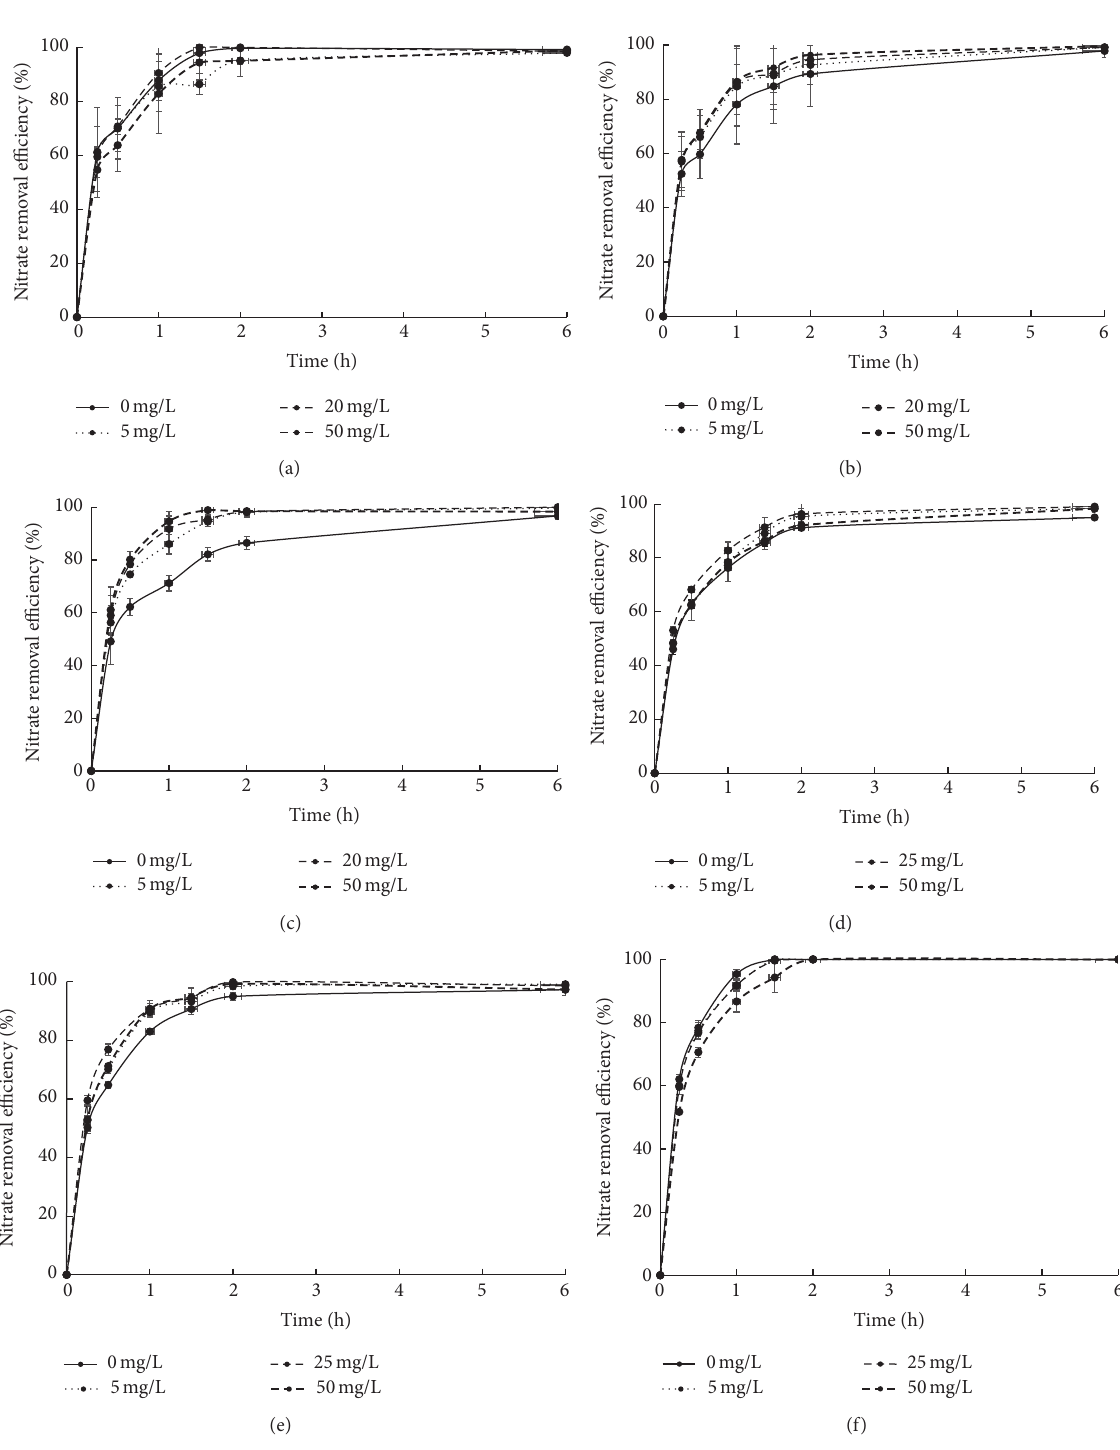
Figure 3: ((a)–(c)) Nitrate removal efficiency in the reactors with different concentrations of Si NPs. Nitrate removal efficiency of (a) the first cycle, (b) the third cycle, and (c) the sixth cycle. ((d)–(f)) Nitrate removal efficiency in the reactors with different concentrations of Fe 2 O 3 NPs. Nitrate removal efficiency of (d) the first cycle, (e) the third cycle, and (f) the sixth cycle. Mean ±